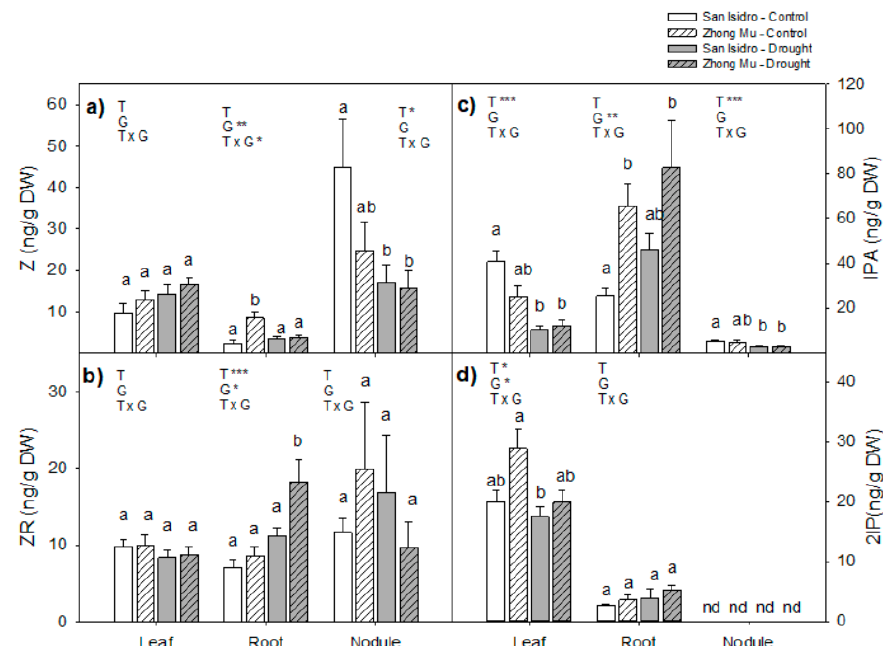
Figure 5. Cytokinins content in leaves, roots and nodules under control and drought condition in two cultivars of Medicago sativa : San Isidro and Zhong Mu: ( a ) trans-zeatin (Z), ( b ) trans-zeatin riboside (ZR), ( c ) isopentenyladenosine (IPA) and ( d ) isopentenyl adenine (2iP). Each value represents the mean ± SE ( n = 6). The different letters indicate significant differences ( p < 0.05). Asterisks indicate significant differences: * p < 0.05, ** p < 0.01, *** p < 0.001, in the two-way ANOVA for water-stress and cultivars.